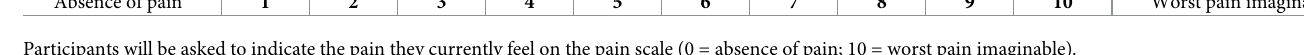
The percutaneous EVI is performed as usual except for the autohypnosis software that will run during the intervention in the virtual reality group. The medical team will provide pain and anxiolytic medication if needed during the inter- vention at the operator’s discretion and depending on the patient’s condition. Immediately after the intervention, participants will fill a second self-questionnaire (postoper- ative questionnaire) to report anxiety and pain felt during the intervention (Tables 1 and 2). A clinical visit at 3 months, as part of the standard clinical protocol, is planned for late assessment. Participants will fill a third self-questionnaire on anxiety (Table 1), the visual ana- log scale for pain (Table 2), and remembered per-procedural impressions (Table 3). The study flowchart from referral to the last clinical visit is provided in Fig 2. ● Measured outcomes The primary outcome is the rated per procedural anxiety, measured by the Spielberger Anxiety State Inventory in French [30]. The Spielberger Anxiety State Inventory is a self-questionnaire of 20 items, each item scores from 1 to 4. The test result is the sum of the 20 items; therefore, the results range from 20 to 80 (Table 1). A high score is related to a high level of anxiety at the moment of the test. Table 2. Pain assessment scale used before and after the endovascular intervention. Absence of pain 1